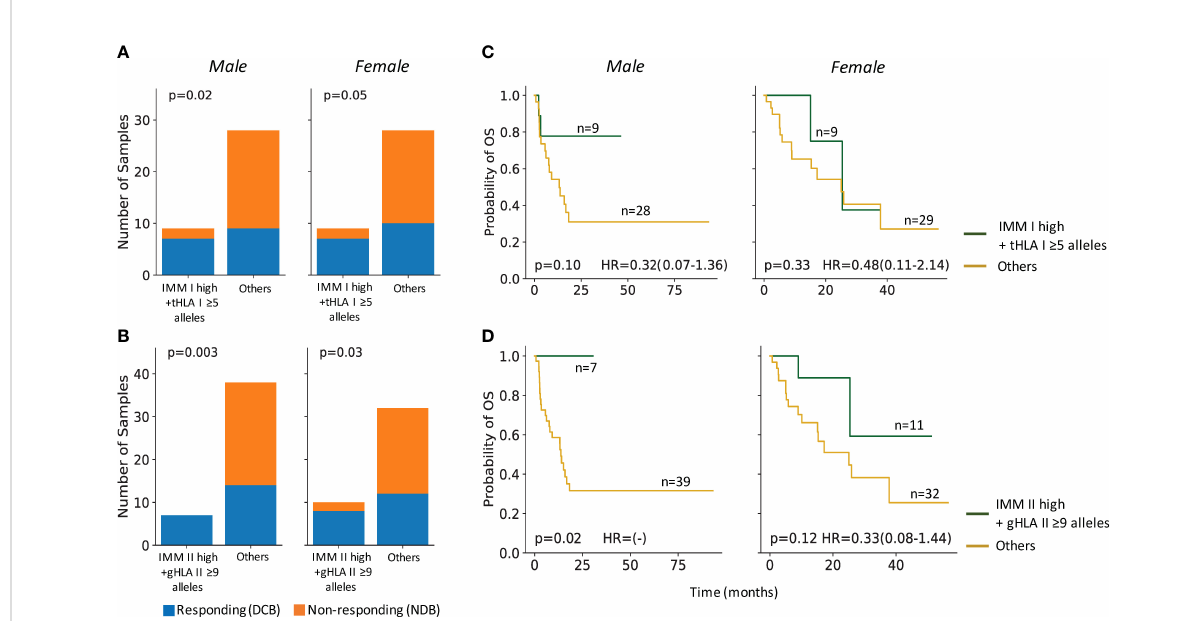
FIGURE 3 HLA heterozygosity combined with immunogenic mutation loads predicted ICI response and survival in males. (A) Male and female tumors with high IMM-I loads and high tumor HLA I diversity (tHLA I ≥ 5) co-occurred with response to ICI treatments (male Fisher ’ s Exact p=0.02, female Fisher ’ s Exact p=0.05). (B) Both male and female tumors with high HLA II restricted IMMs and high germline HLA II diversity (gHLA II ≥ 9) co-occurred with ICI response (male: Fisher ’ s Exact p=0.003; female: Fisher ’ s Exact p=0.03). (C) Male patients with high tumor IMM-I loads and high tumor HLA I diversity trended towards longer overall survival (OS) (log-rank p=0.1), while their female counterparts did not (log-rank p=0.33). (D) Combined high tumor IMM-II loads and high germline HLA II diversity was associated with signi fi cantly longer OS among males (log-rank p=0.02) but not females (log-rank p=0.12). Hazard ratio (HR) shown with 95% con fi dence